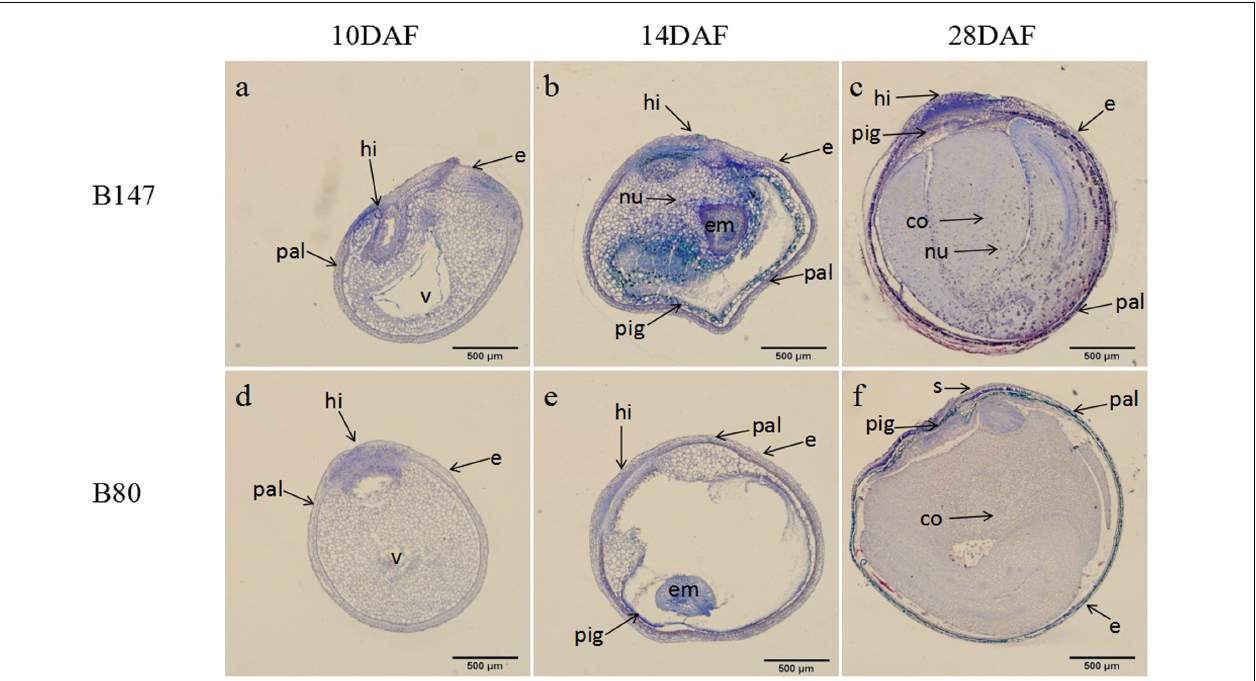
FIGURE 2 | Changes of flavonoids during seed development of brown-seeded and yellow-seeded B. rapa . (a–c) Distribution of flavonoids in seed coat development at 10 DAF, 14 DAF, and 28 DAF in B147. (d–f) Distribution of flavonoids in seed coat development at 10 DAF, 14 DAF, and 28 DAF in B80. Black arrows, accumulation site for flavonoids; pal, palisade layer; hi, hilum; e, epidermis; nu, nucleus; v, vacuole; em, embryo; pig, pigment layer; s, subepidermis; co,